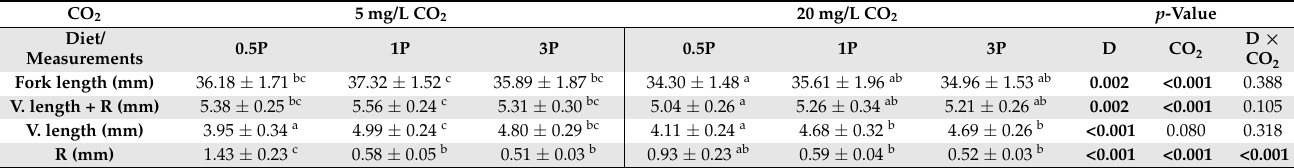
Table 4. Vertebral centra measurements. The analysis was performed on X-ray images of the vertebral column in animals fed diets containing different levels of total P 0.5P (6.3 g/kg), 1P (9.0 g/kg), and 3P (26.8 g/kg) which were reared in conditions with no CO 2 injected (5 mg/L) or with injected CO 2 (20 mg/L). Fork length of animals used for this analysis and vertebral (V) length + radiolucent space (R) were reduced in 0.5P/20CO 2 animals. The extent of vertebral length was reduced in 0.5P animals irrespective of the CO 2 treatment. Radiolucent space was significantly increased in 0.5P/5CO 2 animals. The statistically significant differences among groups (within a row) are indicated by different lowercase superscript letters. If none of the letters are the same, differences are significant. The significant values ( p ) for CO 2 , diet (D), and their interaction are